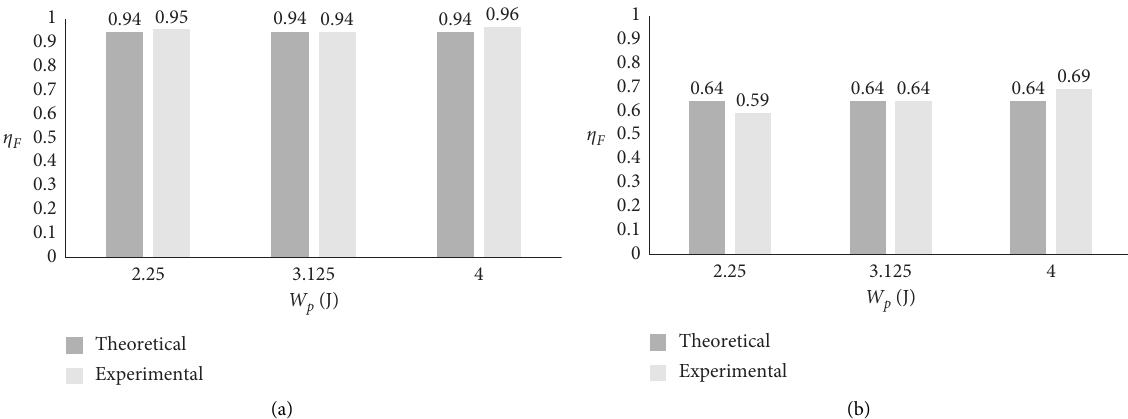
Figure 15: Comparison of the theoretical and measured transfer efficiency at drilling tool joints under different impact energies. (a) K Fmr � 0.13, flange interface. (b) K Tmr � 0.42 and K Tczr � 0.3, screw